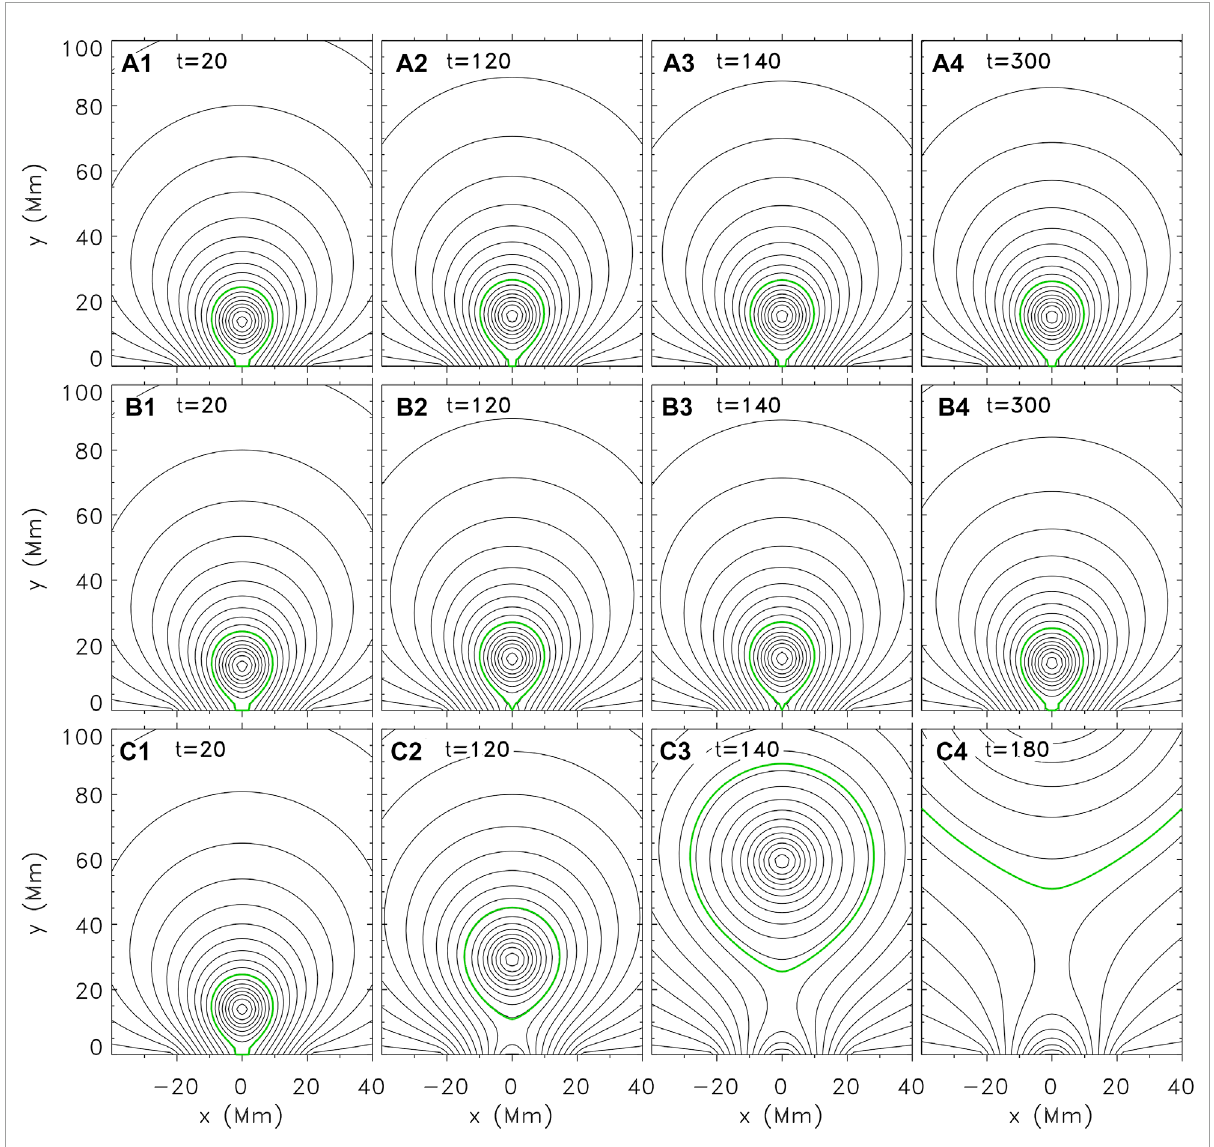
FIGURE 5 The temporal evolution of the flux rope for Case IV. Panels (A1–A4) illustrate the evolution of the flux rope during the relaxation to simulate the equilibrium state in Figure 4G . Panels (B1–B4) illustrate the evolution of the flux rope during the relaxation to simulate the equilibrium state in Figure 4K , which is the equilibrium state right before Φ z = Φ c zc is reached under the resistive condition; Panels (B1–B4) illustrate the evolution right after Φ z = Φ c zc is reached under the resistive